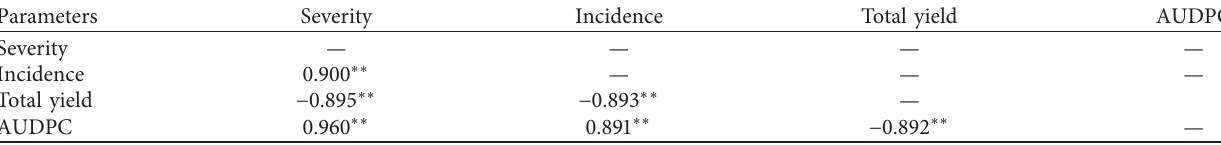
Table 7: Association analysis between disease parameters and yield on potato